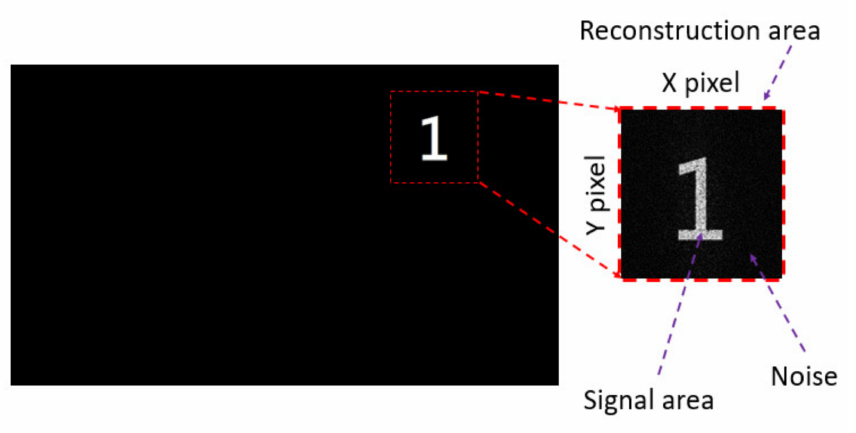
Figure 7. Schematic diagram of area reconstruction, signal reconstruction, and